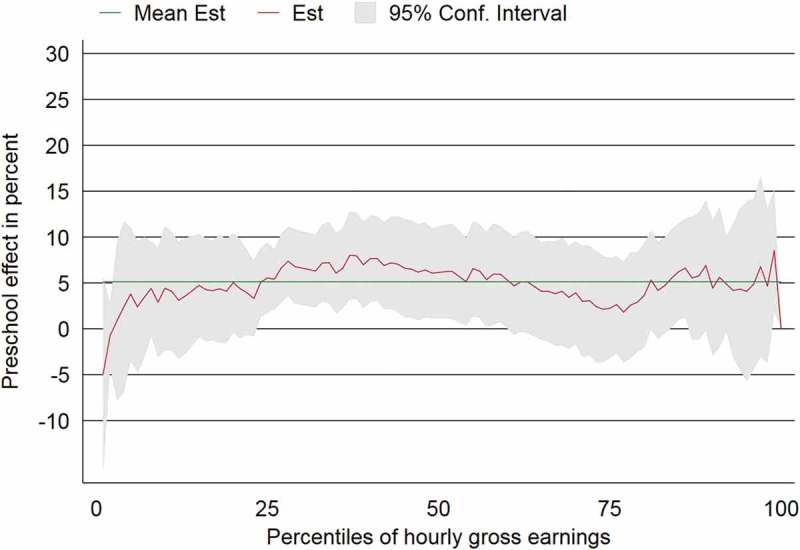
Preschool conditional difference across the gross earnings distribution including own education.